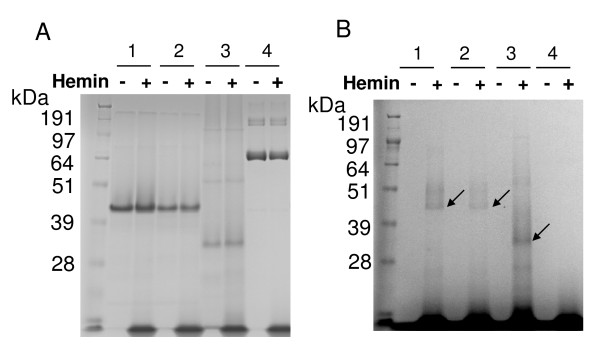
Hemin binding of various rHBP35 proteins. Two μg each of rHBP35(Q22-P344) (lane 1), rHBP35 (Q22-P344 with C48S C51S) (lane 2), truncated rHBP35(M135-P344) (lane 3), or lactoferrin as a negative control (lane 4) was treated with or without 1.5 μl of 1.25 mM hemin for 2 h at room temperature. A, CBB staining; B, peroxidase activity staining. Arrowheads indicate the hemin binding proteins.